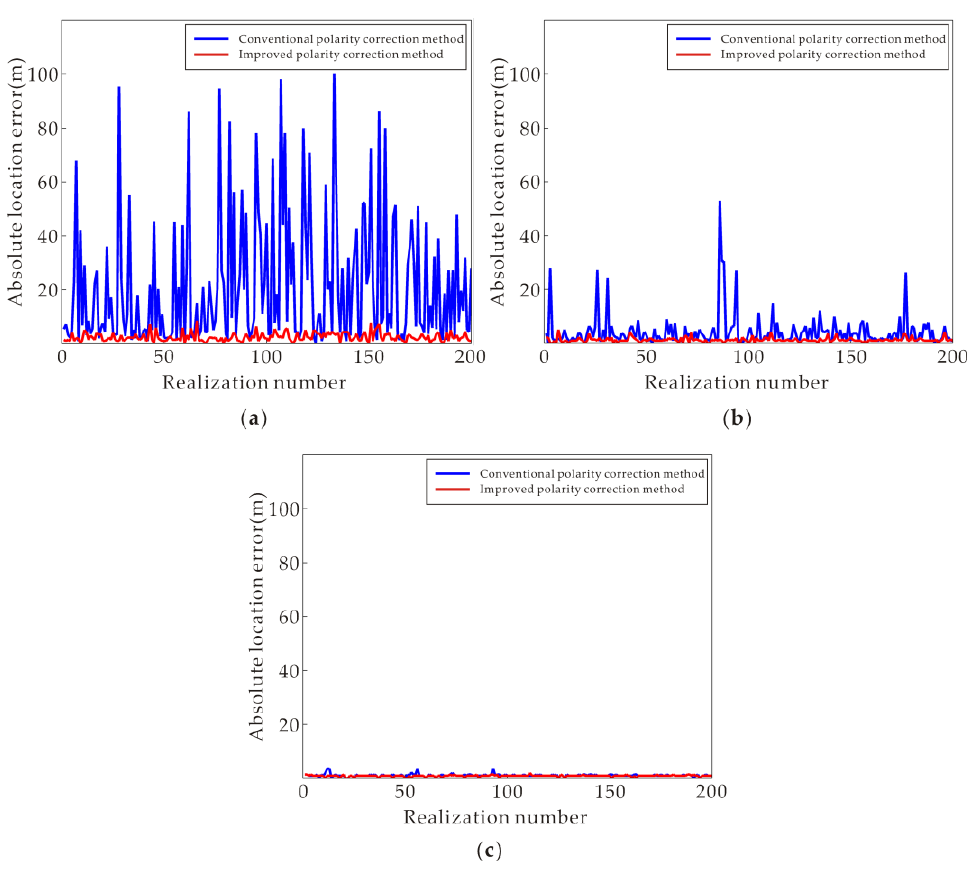
Figure 6. Comparison of absolute location errors with the utilization of same corresponding 200 realizations as in Figure 5 using different SNR levels of ( a ) 0.15, ( b ) 0.25 and ( c ) 0.5.